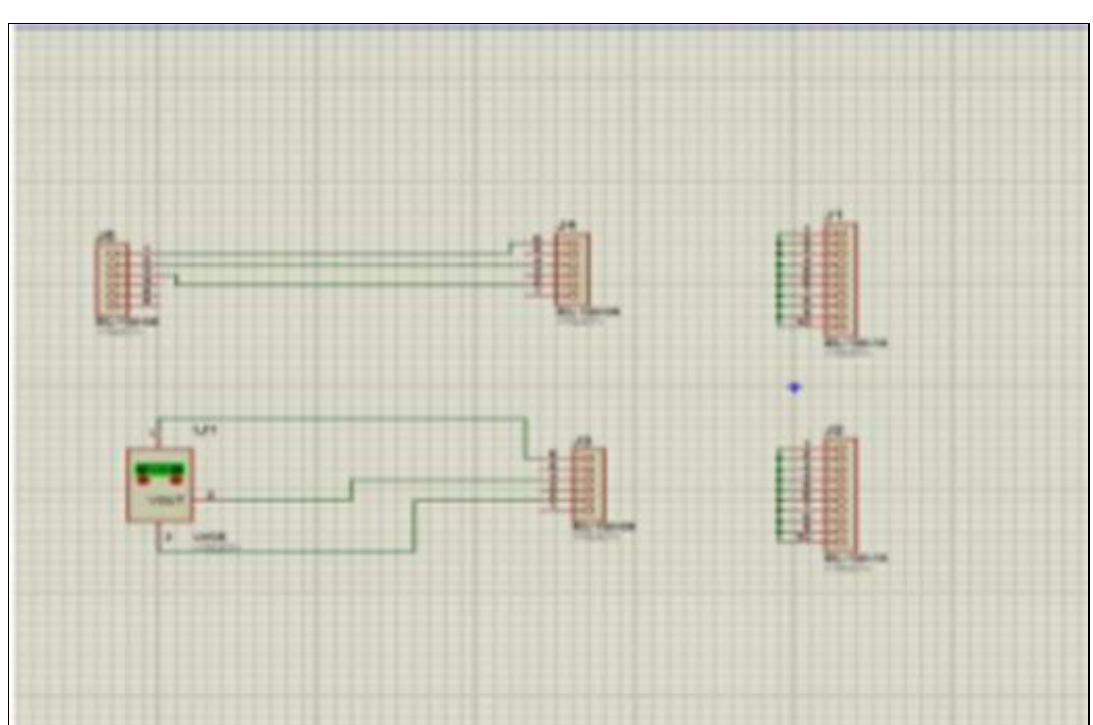
Figure 8: The schematic diagram for